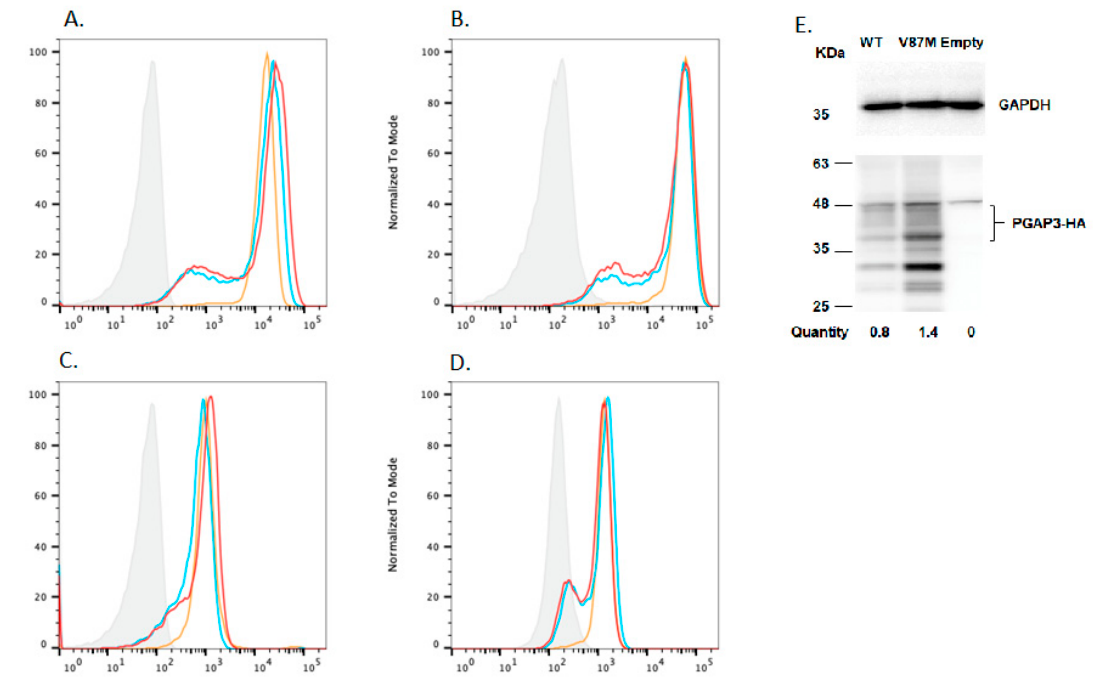
Figure 3. The effect of c.259G>A mutant hPGAP3 , driven by the pCMV promoter, on the expression of GPI-APs in PGAP2 - and PGAP3 -deficient Chinese hamster ovary (CHO) cells. Isotype (grey); pCMV WT hPGAP3 -HA (red); pCMV c.284A>G (p. Val87Met) mutant hPGAP3 -HA (blue); pCMV empty (yellow). The wide type hPGAP3 and hPGAP3 c.259G>A reduced the expression of GPI-APs to similar extents ( A ). CD59; ( B ). CD55; ( C ). uPAR; ( D ). FLAER in PGAP2- and PGAP3- double deficient CHO cells. ( E ). Western blot analysis of the hPGAP3-HA proteins expressed in CHO cells by the pCMV promoter. The glycosylated PGAP3 proteins were detected by the anti-HA antibody. As for the quantity, each band intensity was normalized by that of GAPDH as a loading control and by luciferase activities as a transfection efficiency.